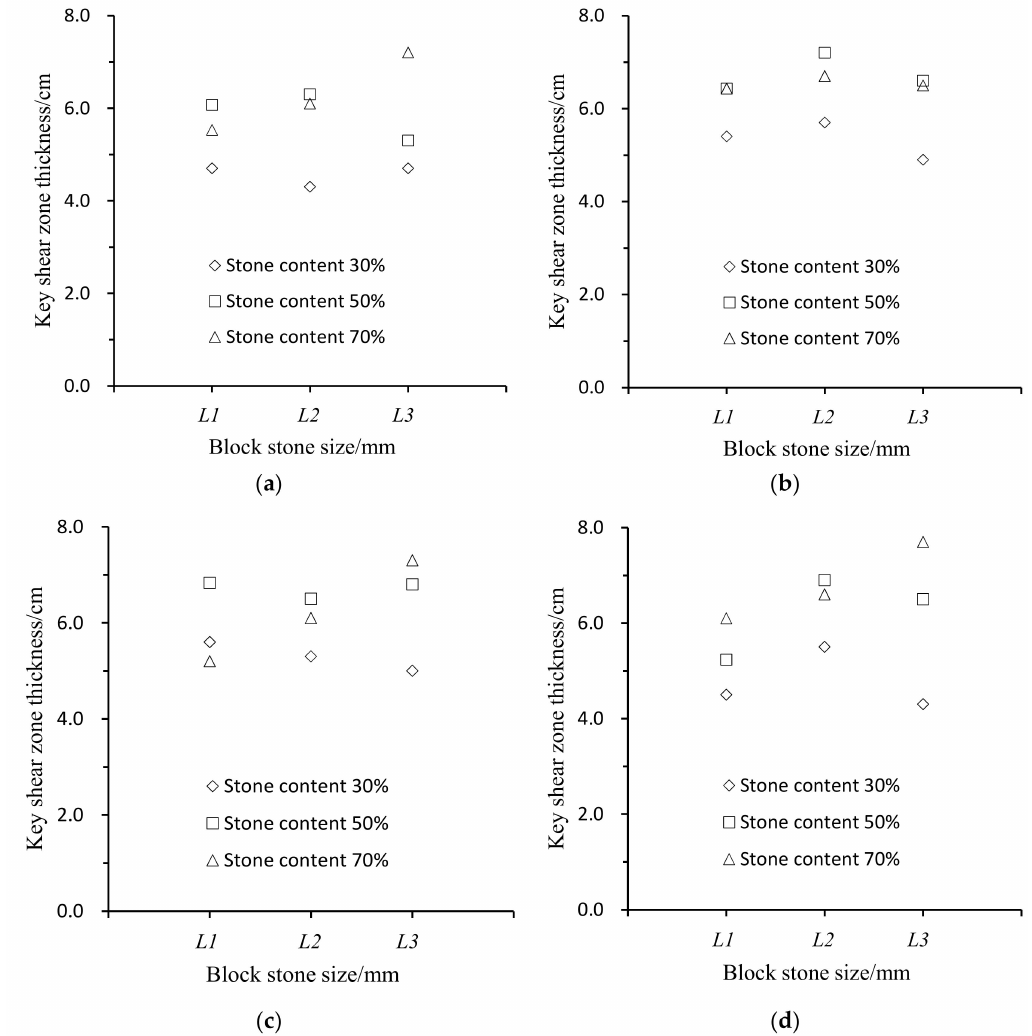
Figure 18. Variation in the key shear zone thickness with increasing stone sizes under di ff erent vertical pressures. ( a ) 50; ( b ) 200; ( c ) 300; ( d ) 400 kPa.